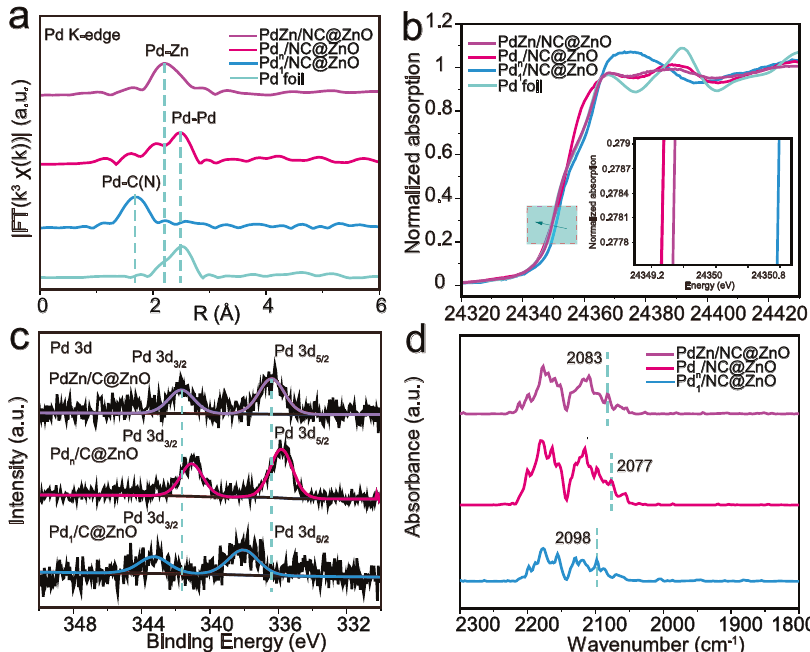
Fig. 2 X-ray absorption spectroscopy characterization of the catalysts. a FT-EXAFS spectra at the Pd k-edge of PdZn/NC@ZnO, Pd n /NC@ZnO, and Pd 1 / NC@ZnO with Pd foil as the reference. b XANES spectra at the Pd k-edge of PdZn/NC@ZnO, Pd n /NC@ZnO, and Pd 1 /NC@ZnO with Pd foil as the reference . c XPS spectra in Pd 3d region of PdZn/NC@ZnO, Pd n /NC@ZnO, and Pd 1 /NC@ZnO. d DRIFT spectra for PdZn/NC@ZnO, Pd n /NC@ZnO, and Pd 1